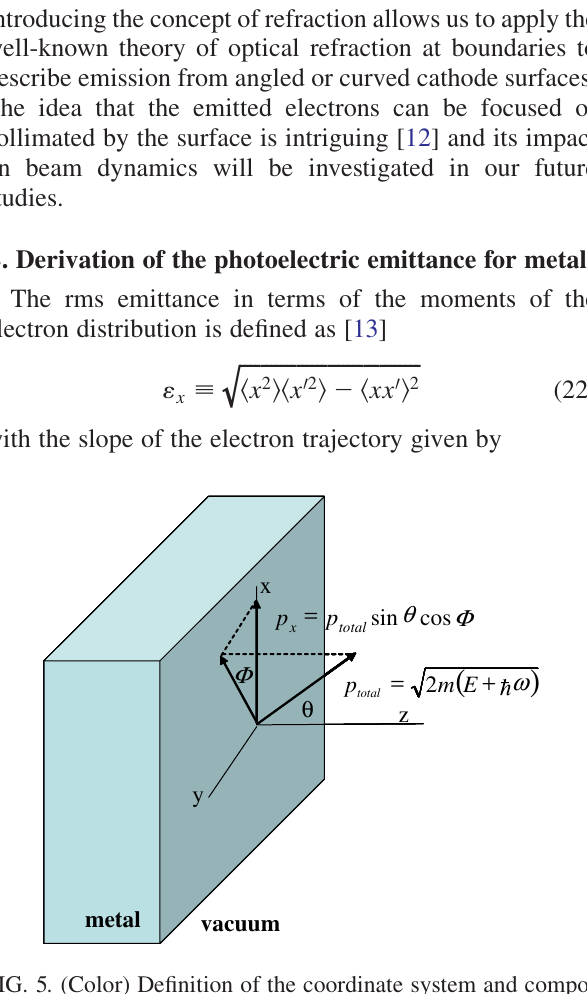
FIG. 4. (Color) Graphical representation of the electron momen- tum inside the cathode and the maximum angle of escape.